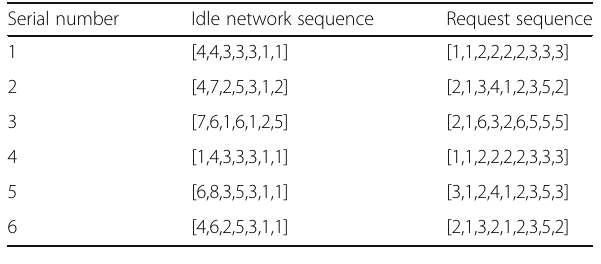
Table 1 Idle network sequence and request sequence Serial number Idle network sequence Request sequence